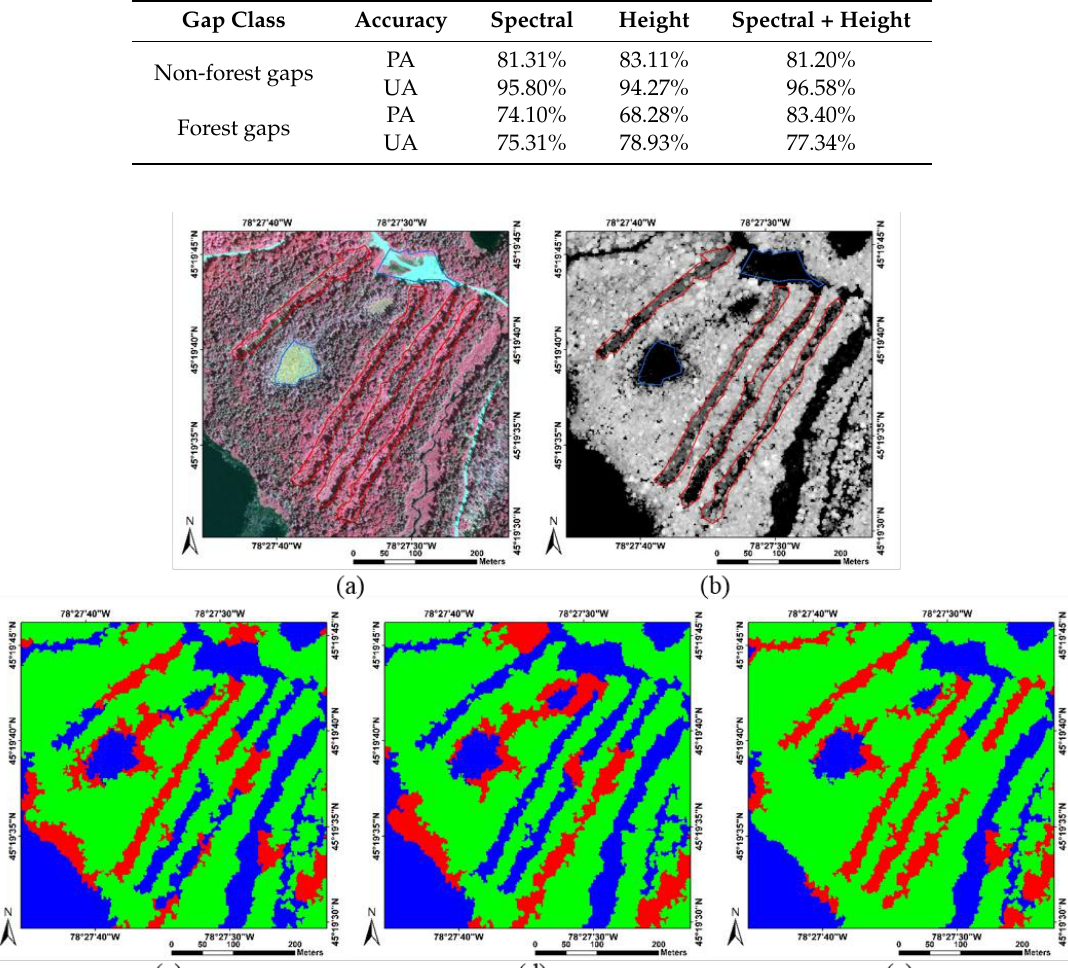
Figure 7. A subset of multispectral image ( a ); CHM ( b ); and canopy gap classification map by spectral ( c ); height ( d ); and spectral + height information ( e ). Blue and red polygons imposed on the multispectral image (a) and CHM (b) represent the reference geo-objects of non-forest and forest gaps, respectively. Blue, red, and green pixels in the classification maps (c–e) represent the non-forest gaps, forest gaps, and tree canopies, respectively.